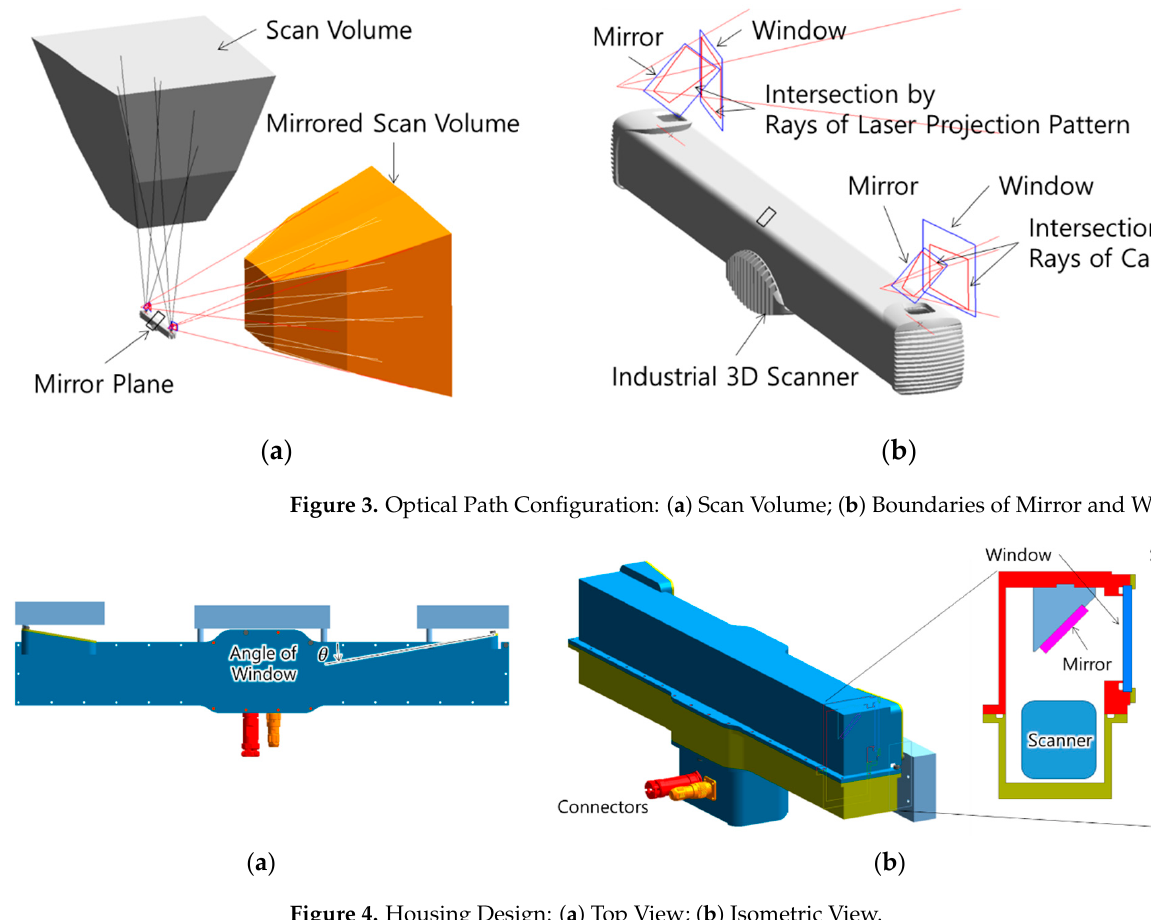
Figure 4. Housing Design: ( a ) Top View; ( b ) Isometric View.